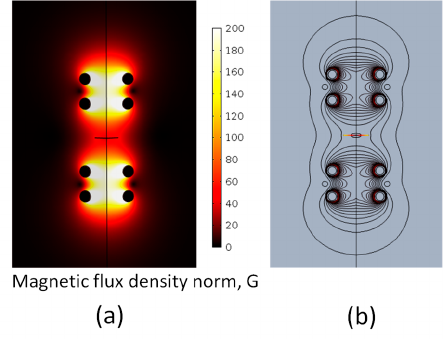
Figure 12. ( a ) Magnetic flux density during the transient study. ( b ) Magnetic flux lines distribution.